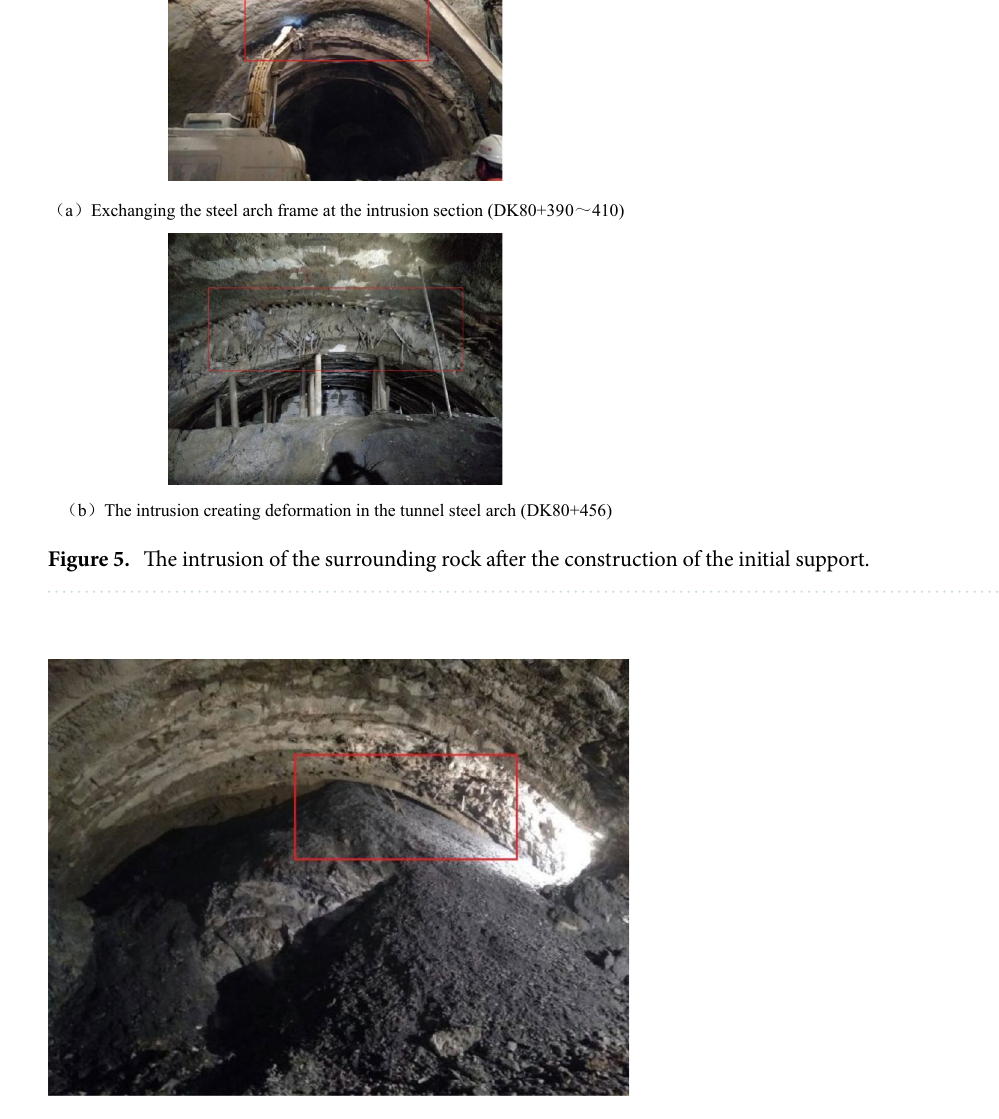
Figure 6. Collapse of the excavated face (DK80 +